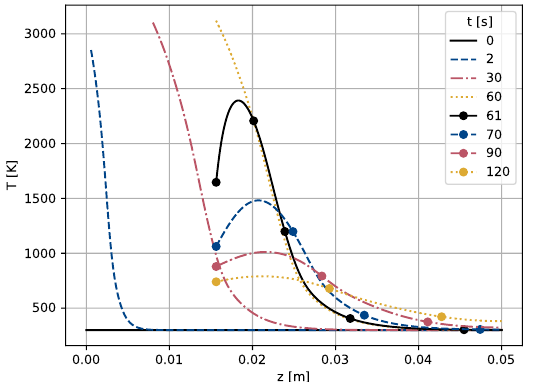
Figure A3. Temperature profiles of Hot-STARSHIP calculation at selected times.